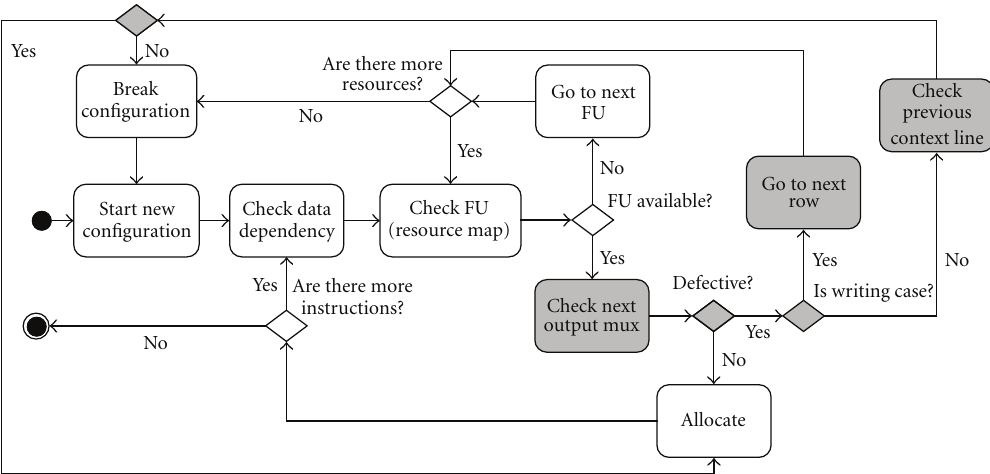
Figure 12: Configuration generation algorithm implemented in BT considering defective units—same steps of defect-free resource allocation (Figure 5) with additional steps for managing defective output multiplexers.